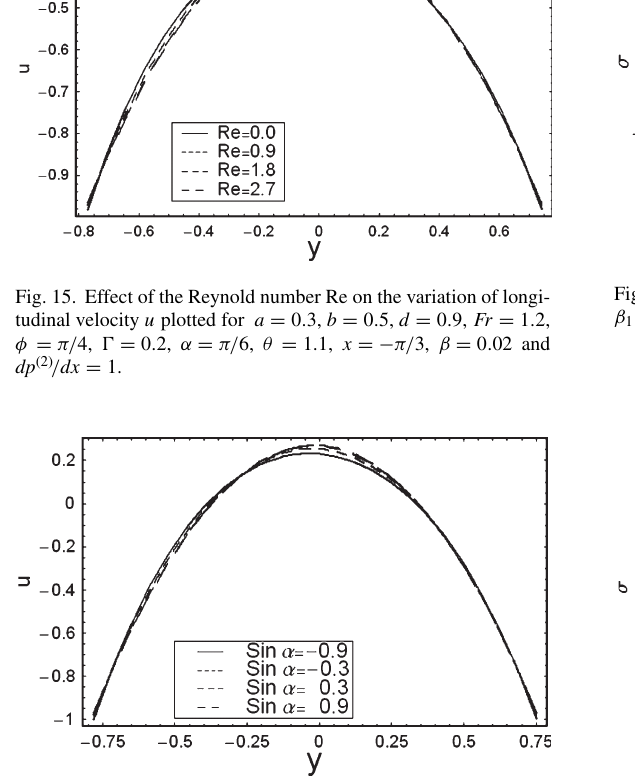
Fig. 16. Effect of sin α on the variation of longitudinal velocity u plottedfor a = 0 . 3, b = 0 . 5, d = 0 . 9, Fr = 1 . 3, φ = π/ 4, (cid:15) = 0 . 03, Re = 2, θ = 1 . 5, x = − π/ 3, β = 0 . 02 and dp (2) /dx = 1.